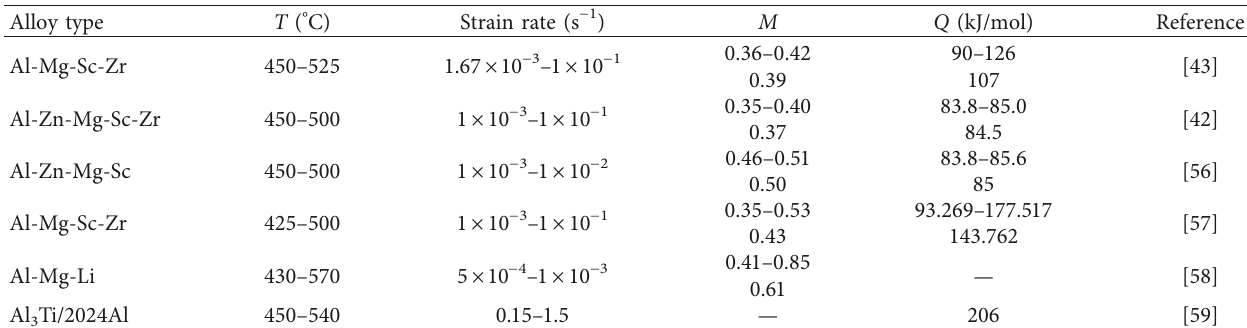
Table 2: Reference data to illustrate range and average values of m and Q during superplastic